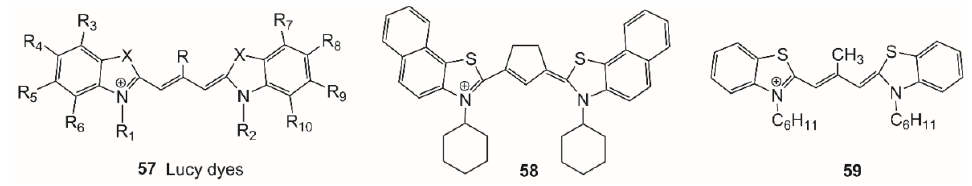
Figure 13. Structures of trimethine cyanines 57 – 59